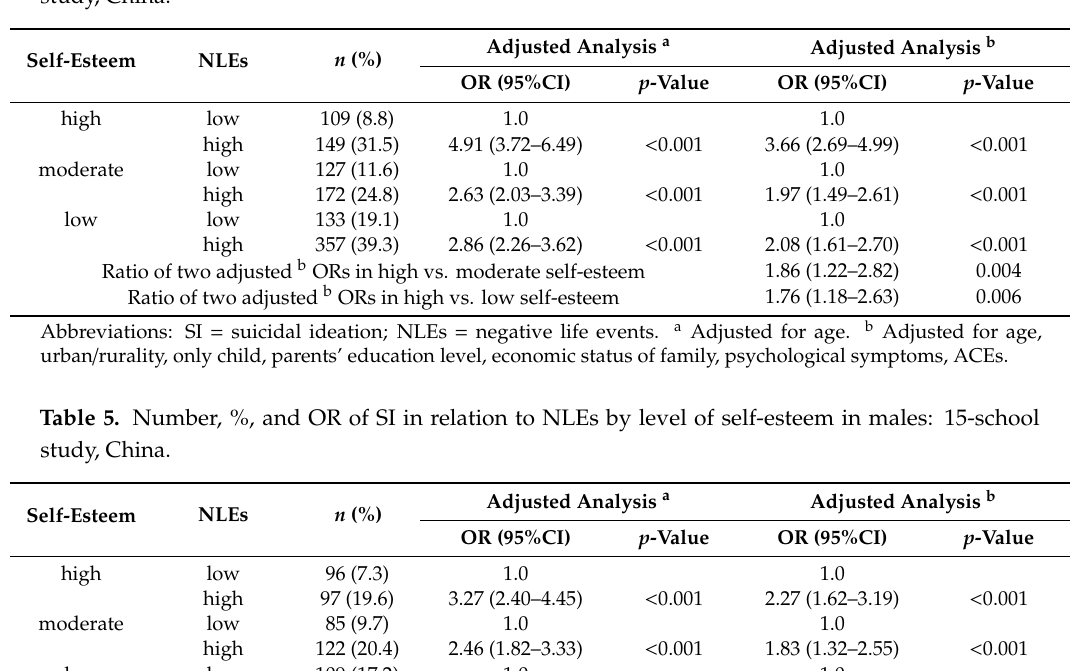
Table 4. Number, % and OR of SI in relation to NLEs by level of self-esteem in females: 15-school study, China.